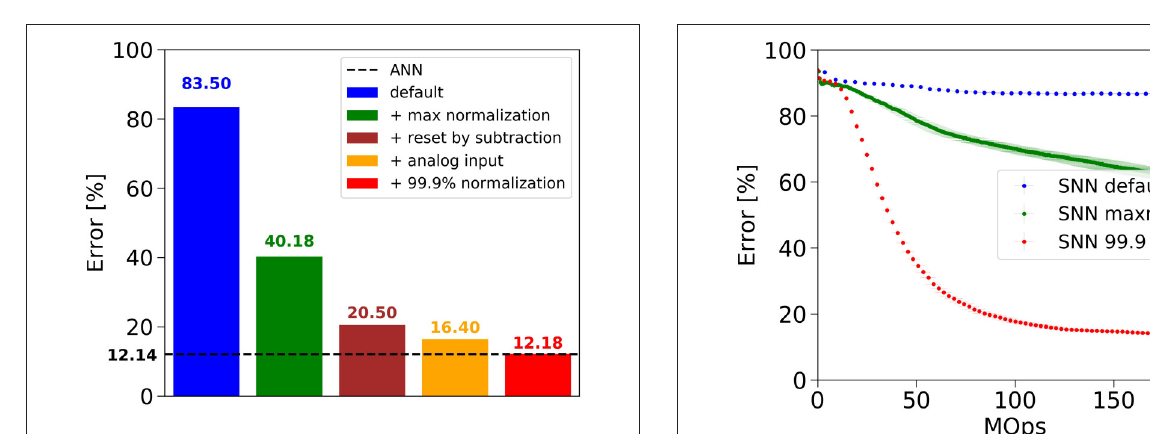
FIGURE 2 | Influence of novel mechanisms for ANN-to-SNN conversion on the SNN error rate for CIFAR-10. and convergence is much faster. Empirically, the best results